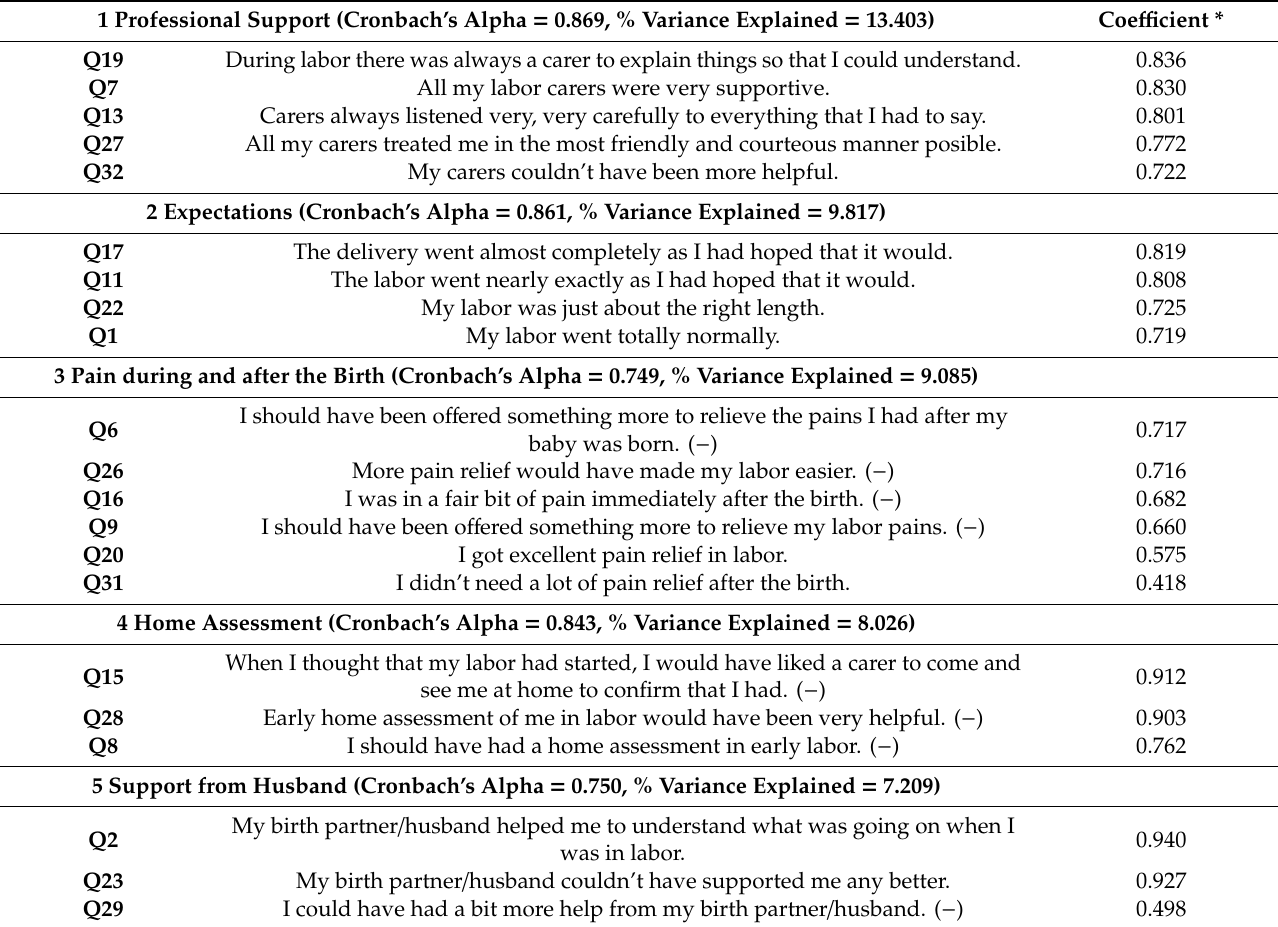
Table 3. Analysis of each dimension and items on the scale after the removal of items Q12 and